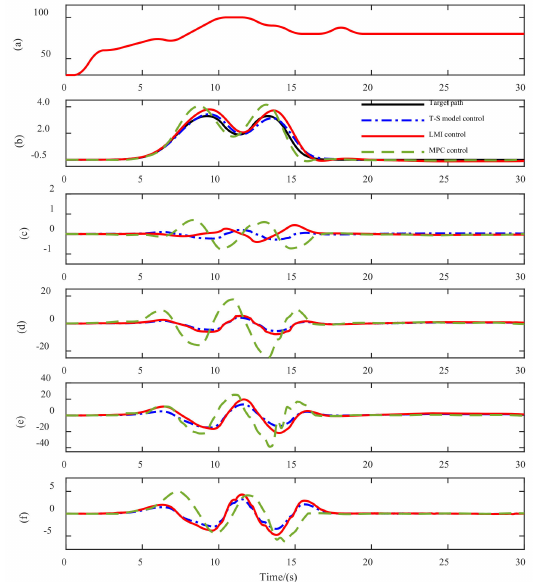
Figure 5. ( a ) Speed (km/h), ( b ) lateral displacement (m), ( c ) deviation (m), ( d ) steering torque control input (Nm), ( e ) steering angle ( ◦ ), and ( f ) yaw rate ( ◦ /s).